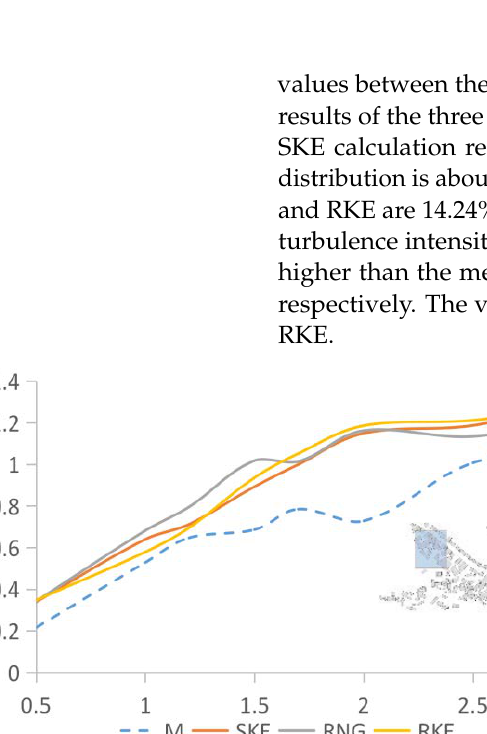
Figure 7. Analysis of measured values and data simulated using SKE, RNG, and RKE in an area with a building density of 35.71%. ( a ) Wind speed comparison between SKE, RNG, RKE, and the measured data. ( b ) Comparison of turbulence intensity between SKE, RNG, RKE, and the measured data.